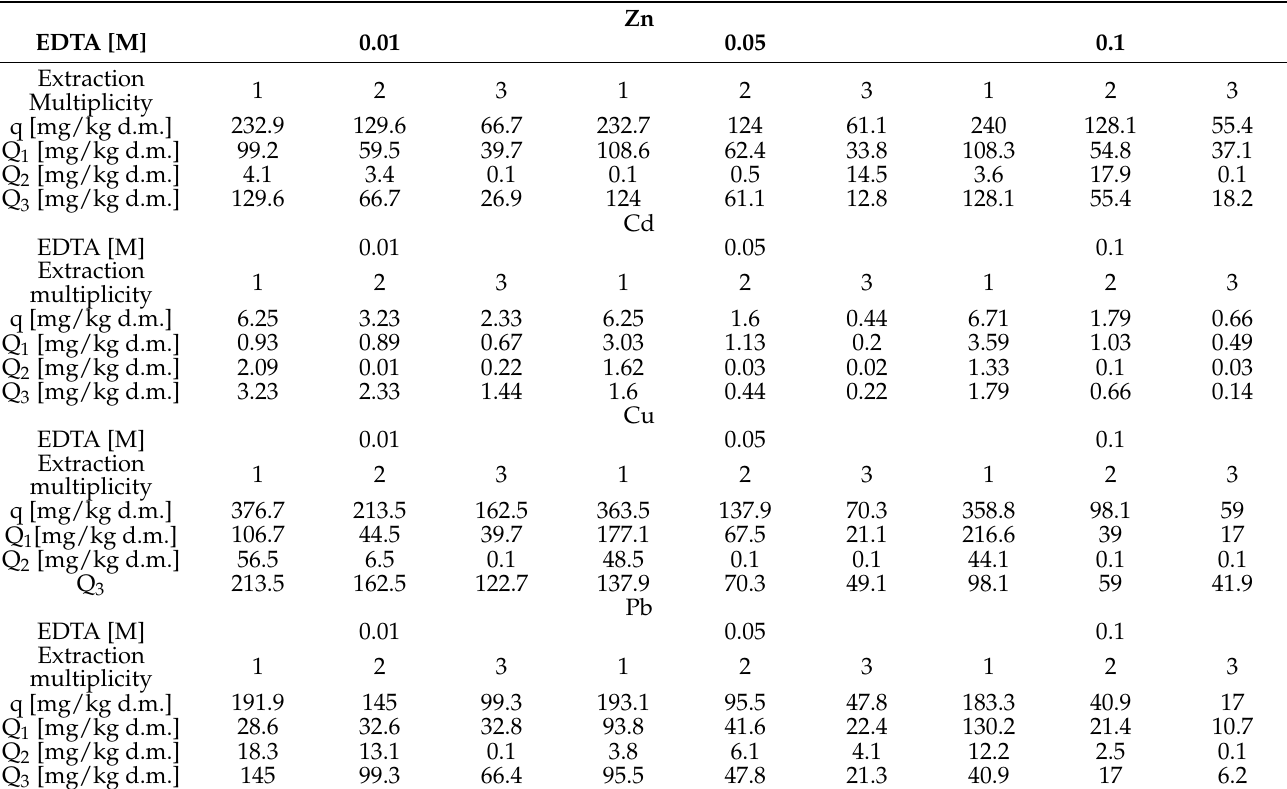
Table 4. The content of the “labile”, “moderately labile” and “not extractable” fraction. Zn EDTA [M] 0.01